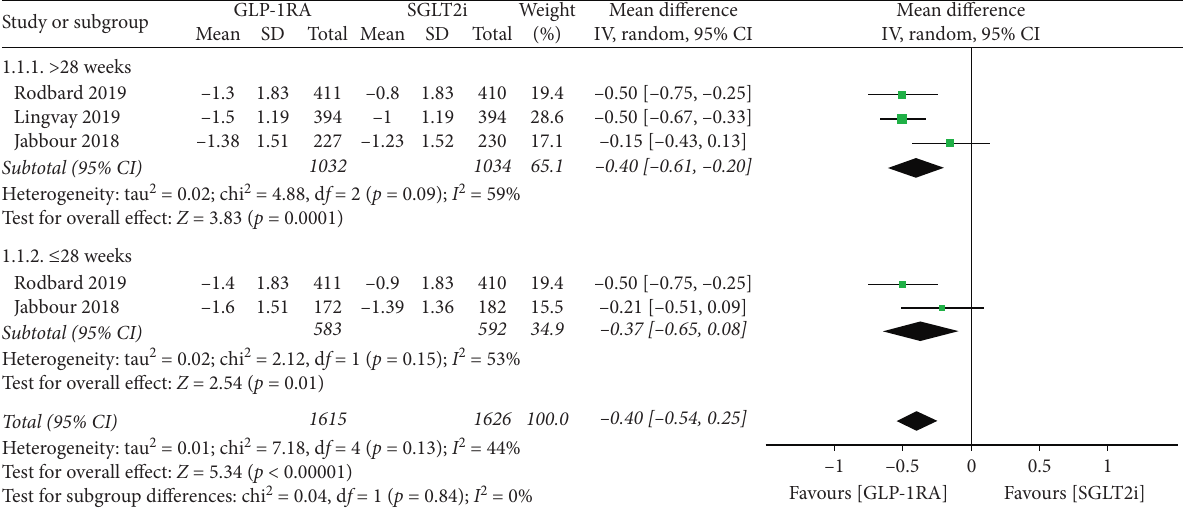
Figure 2: Forest plot for meta-analyses comparing the effect of GLP-1RAs with SGLT-2is in HbA1c. GLP-1RAs: glucagon-like peptide 1 receptor agonists, SGLT-2is: sodium-glucose cotransporter 2 inhibitors, HbA1c: glycated haemoglobin, CI: confidence interval, SD: standard